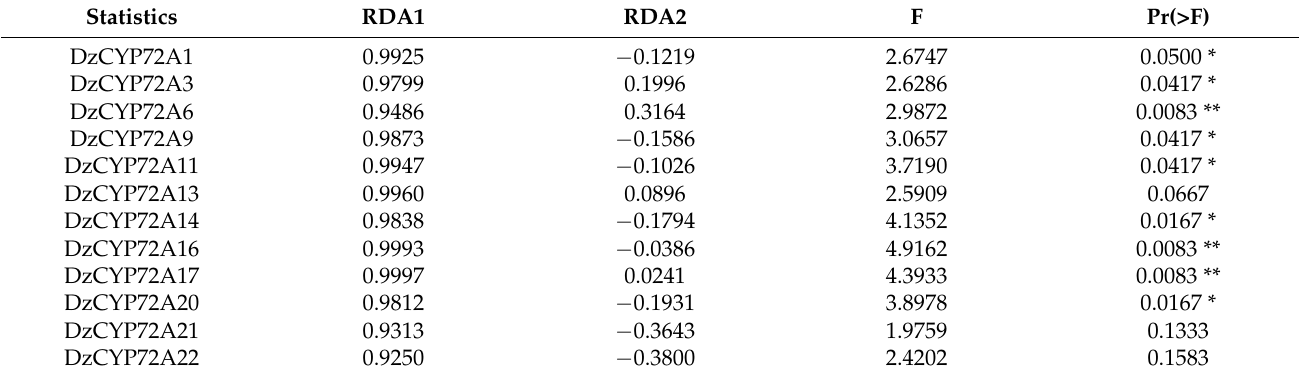
Table 4. Redundancy analysis of steroidal biosynthesis and DzCYP72As in D. zingiberensis